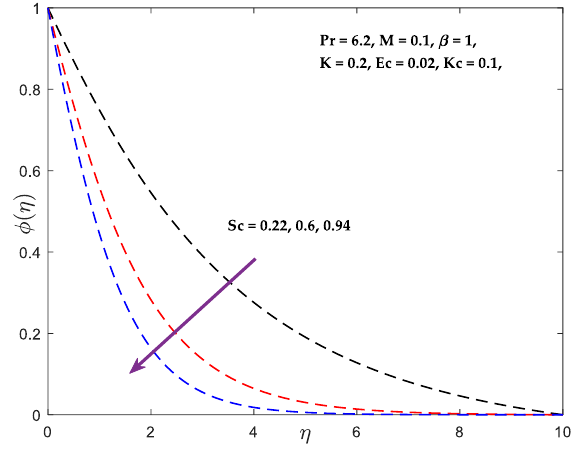
Figure 6. Concentration vs. Sc .